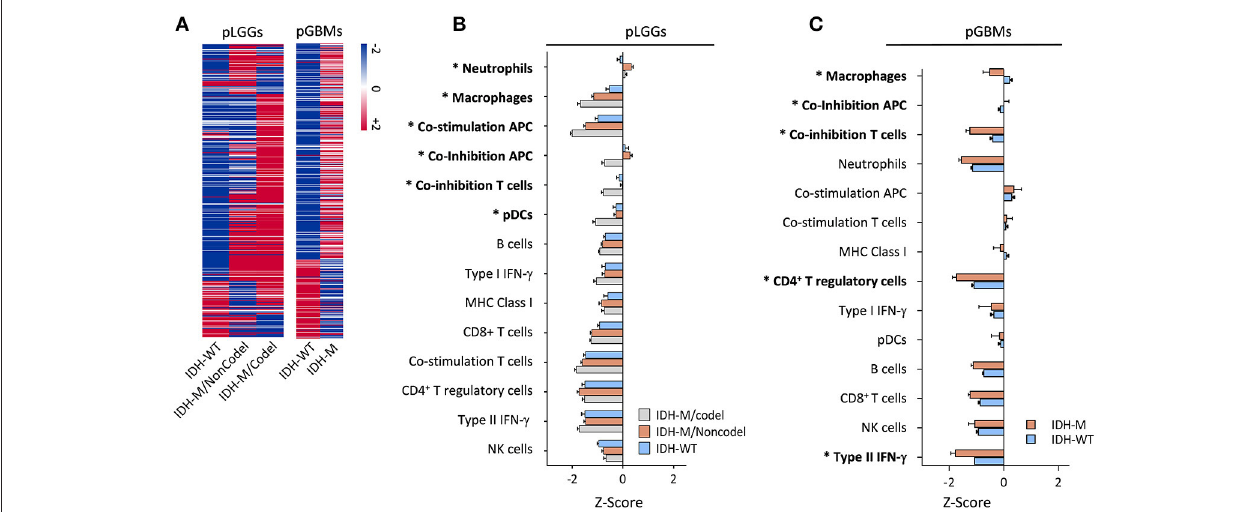
FIGURE 1 | The immunological gene profile in primary LGG subgroups and GBMs with or without IDH1 mutations. (A) Hierarchical cluster of cancer immune-related genes among three LGG subgroups (left panel) and GBMs with or without an IDH1 mutation (right panel). RNA-Seq data from TCGA were analyzed and 750 cancer immune-associated genes ( Cesano, 2015) were used to perform the hierarchical clustering according to the nCounter ® PanCancer Immune Profiling Panel. These genes were imported to log2 normalization and centered by the mean gene expression value. (B,C) Differences in local immune infiltrates and cytolytic activity in the tumors was based on the terminology and data analysis used in a previous report ( Rooney et al., 2015) for the three subgroups of LGGs and GBMs with or without the mutation. These tumor-related, local immune cell subtype/process-associated genes were clustered using Pearson’s correlation among the subtypes. The enrichment scores (Z-scores) of each subgroup were plotted. The LGG patients were subdivided according to IDH1 mutation status and complete deletion of chromosome 1p/19q. Asterisks (*) indicate a significant difference found between the IDH1wildtype and -mutant tumors. We used mixed-effects analysis of variance (ANOVA) to screen across 14 cell types to assess differences in response among tumor types. The subject was modeled as a random effect nested within tumor type, and tumor type and cell type were both modeled as fixed effects. We specifically compared the IDH-WT tumor type mean to the average of the two IDH-mutated tumor type means within each cell type and assessed FDR-adjusted P -values at FDR =